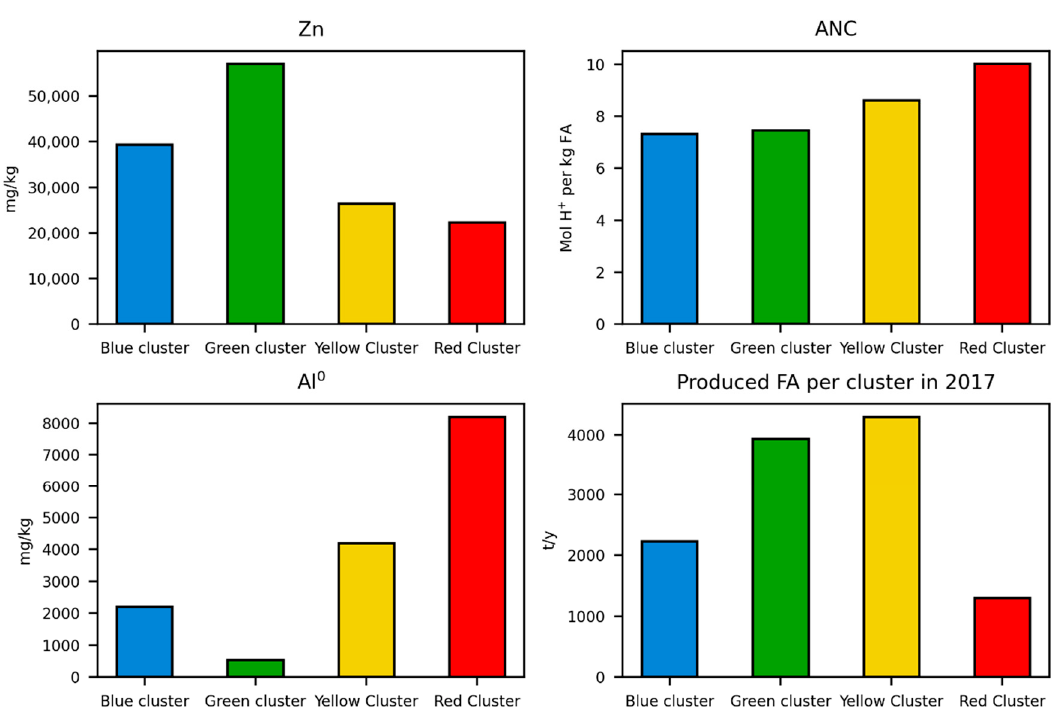
Figure 6. Average Zn and A l0 concentration as well as average produced FA per plant and the average ANC for each cluster.